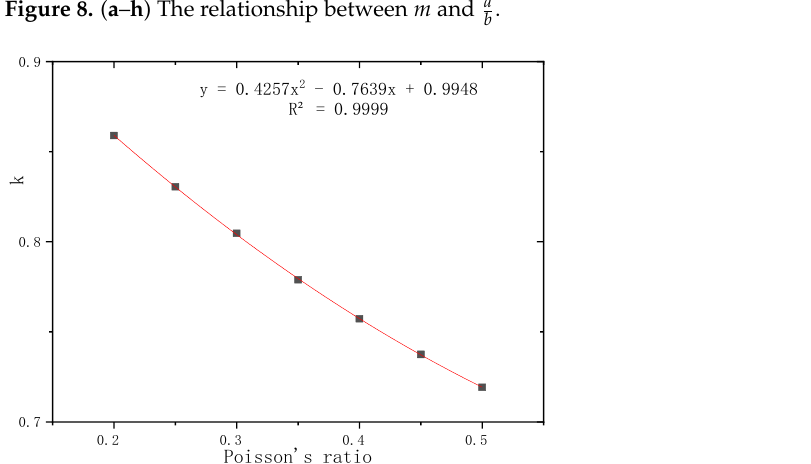
Figure 8. The relationship between m and